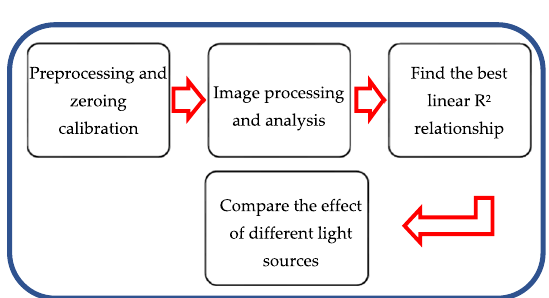
Fig. 4 Experimental process of direct bilirubin test papers using image recognition and different light